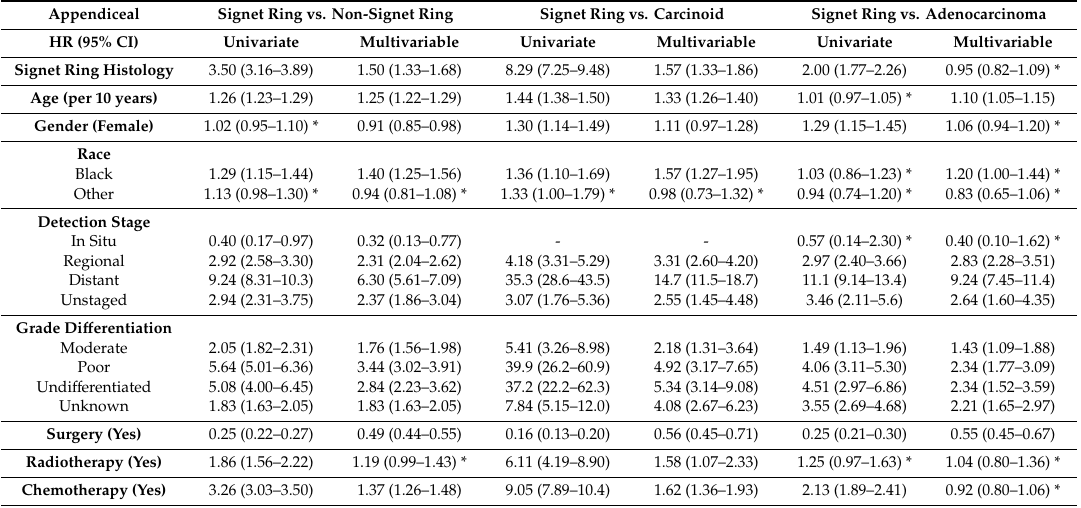
Table 14. Derived univariate and multivariable Cox-proportional hazard ratios (HR) of mortality for appendiceal